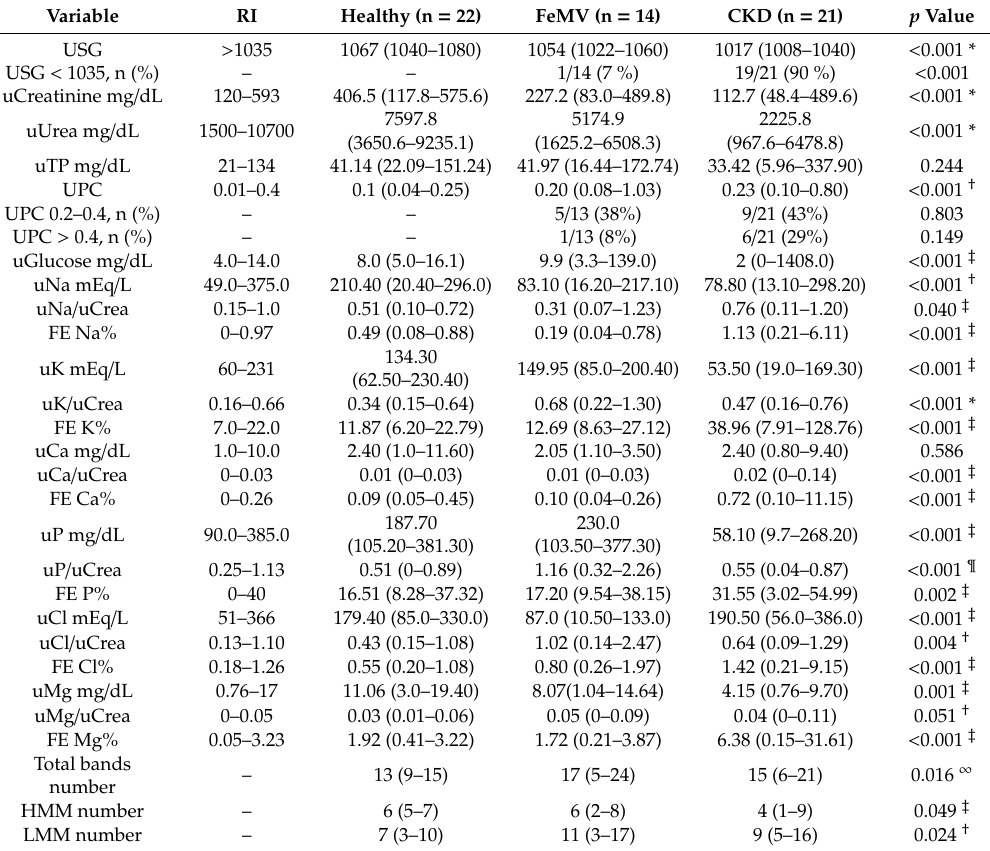
Table 3. Urinalysis and urine chemistry values of cats belonging to the three study groups: Healthy (n = 22), FeMV (n = 14) and CKD (n = 21).